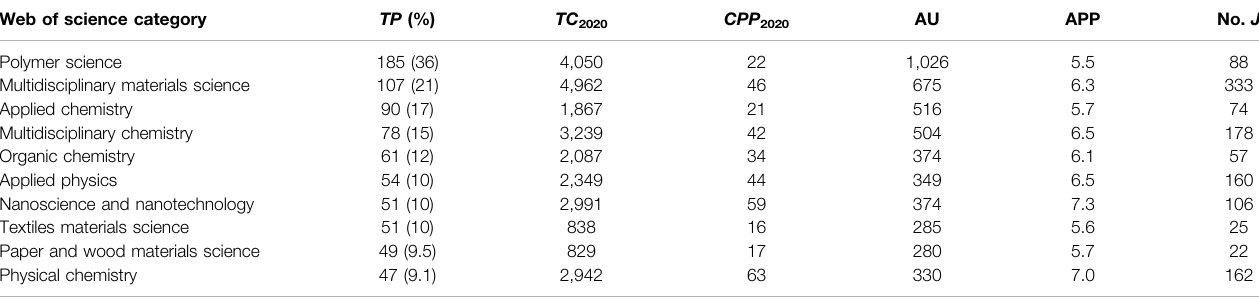
TABLE 2 | The top 10 productive Web of Science categories.